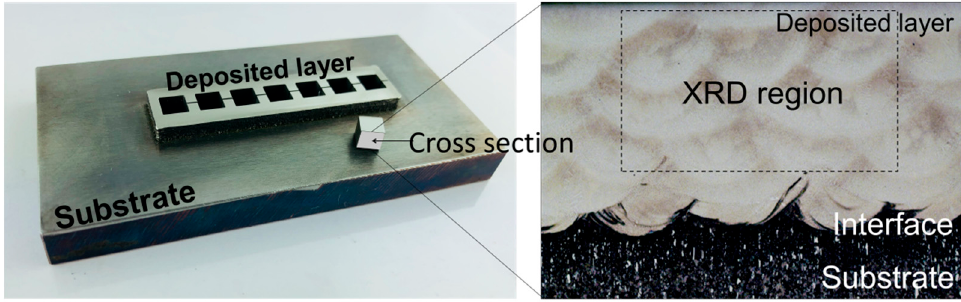
Figure 4. Images of the specimen and cross section for XRD (X-ray diffraction) analysis.